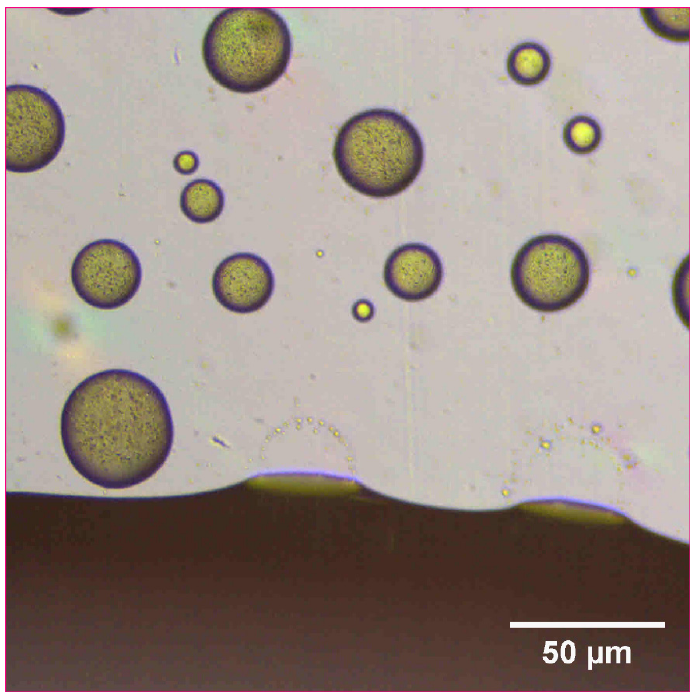
Figure 7. Optical microscope image of 10 mg/mL concentration naproxen nanosuspension after inkjet printing onto a film transparency. A drop of water was added to observe the redispersion of the dried nanosuspension droplets.